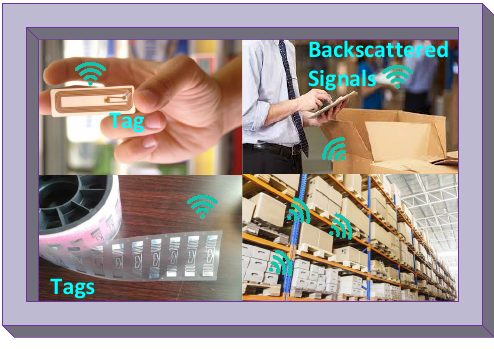
Figure 44. BackCom in